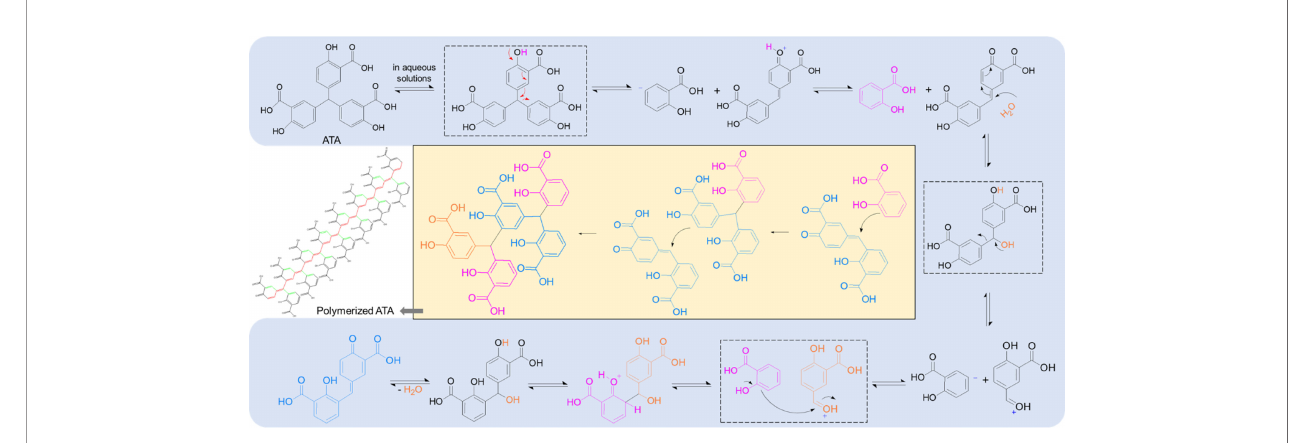
FIGURE 5 | ATA polymerizes in the aqueous solutions and forms conjugation structures. The mechanism with regard to ATA polymer formation, indicating a conjugation structure along the unsaturated carbon backbone (red) as well as across the quinone methide moiety (green), shown in the polymerized ATA structure. ATA, aurintricarboxylic